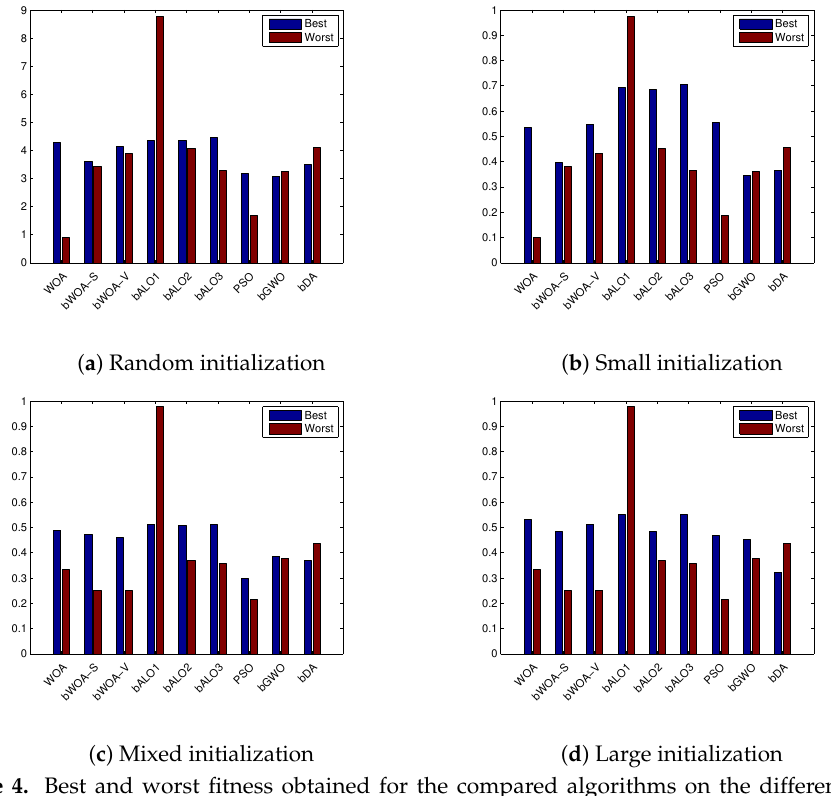
Figure 4. Best and worst fitness obtained for the compared algorithms on the different datasets averaged over the four initialization methods.